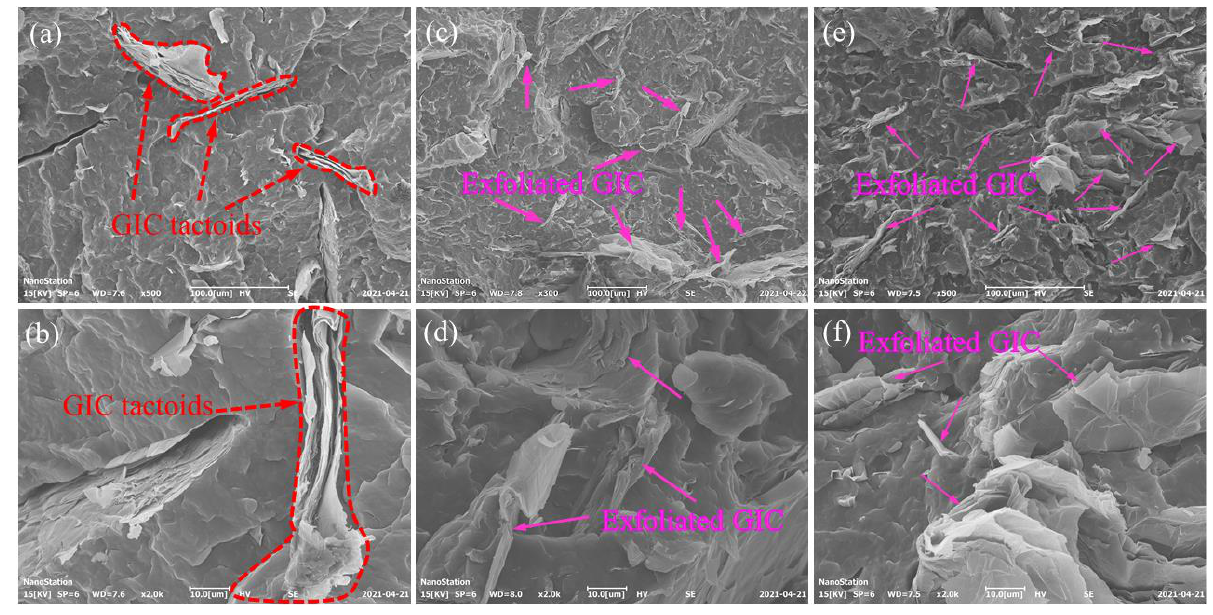
Figure 1. SEM micrographs of ( a , b ) PG180, ( c , d ) PG200, and ( e , f ) PG220 samples.